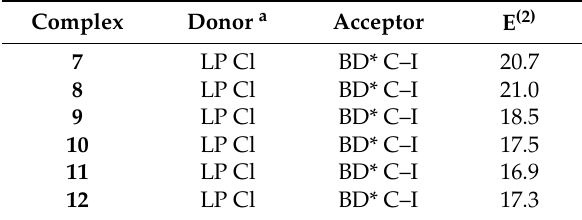
Table 2. Donor and acceptor NBOs with indication of the second-order interaction energy E (2) (kcal/mol) for Complexes 7 – 12 .